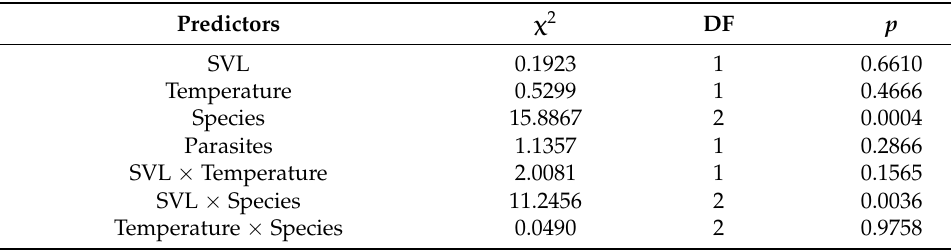
Table 2. Main and interactive effects of snout-vent length (SVL), temperature, species, and log 10 parasite load on the endurance of frogs (slope of jump distance against jump number). These statistical results are from a linear mixed model that also included the identification number of individual frogs as a random